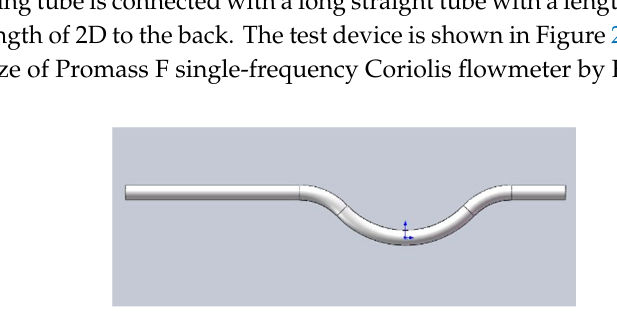
Table 1. Physical parameters of pure water and gas.